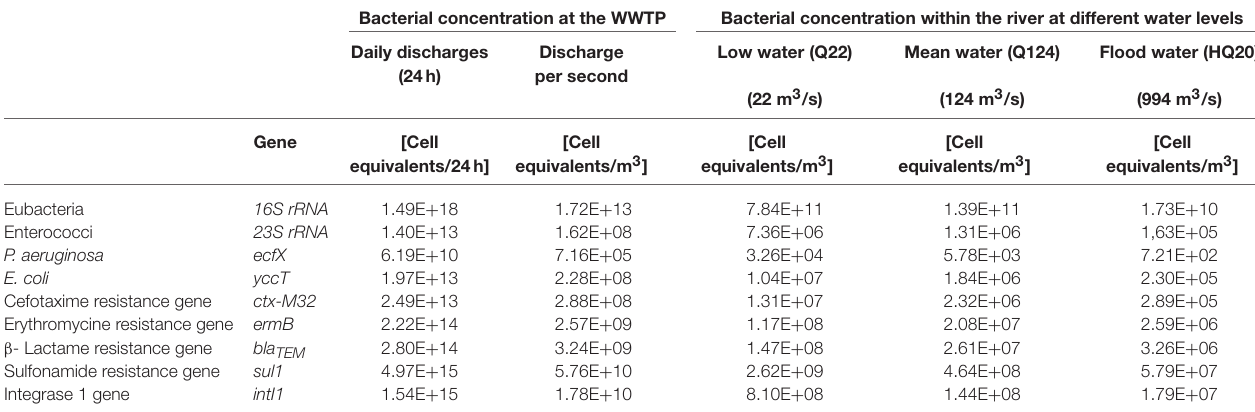
TABLE 1 | Daily load situation of a municipal wastewater treatment plant effluent. Bacterial concentration at the WWTP